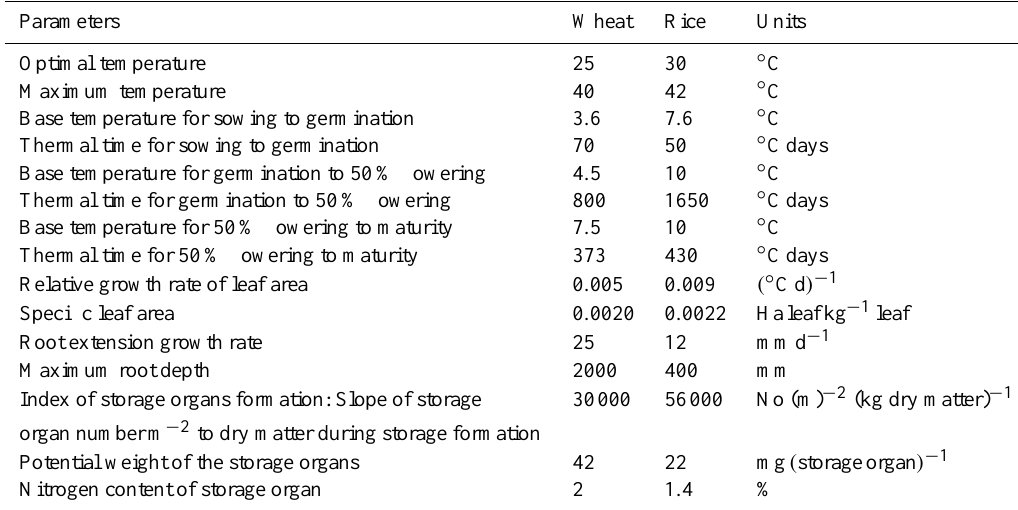
Table 1. JULES-Info parameters for wheat and rice.